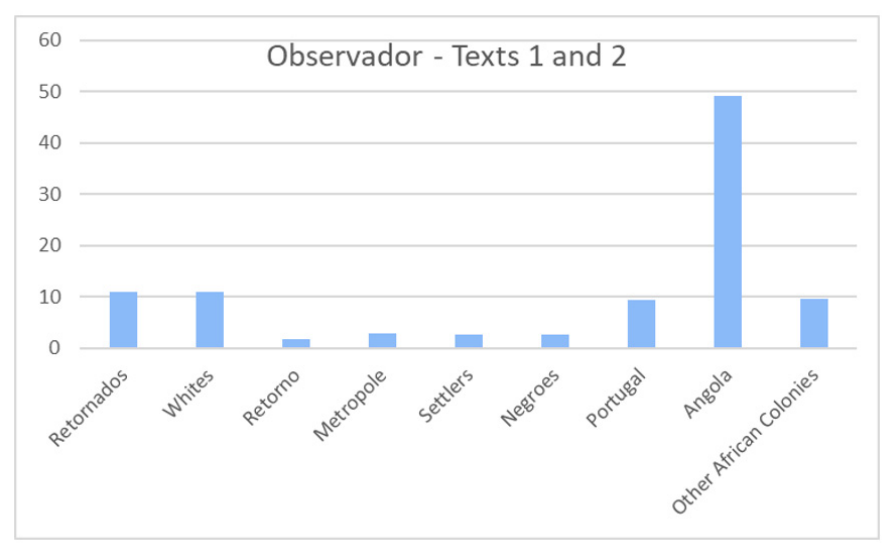
Figure 5. Most prominent words in the two texts of Observador .